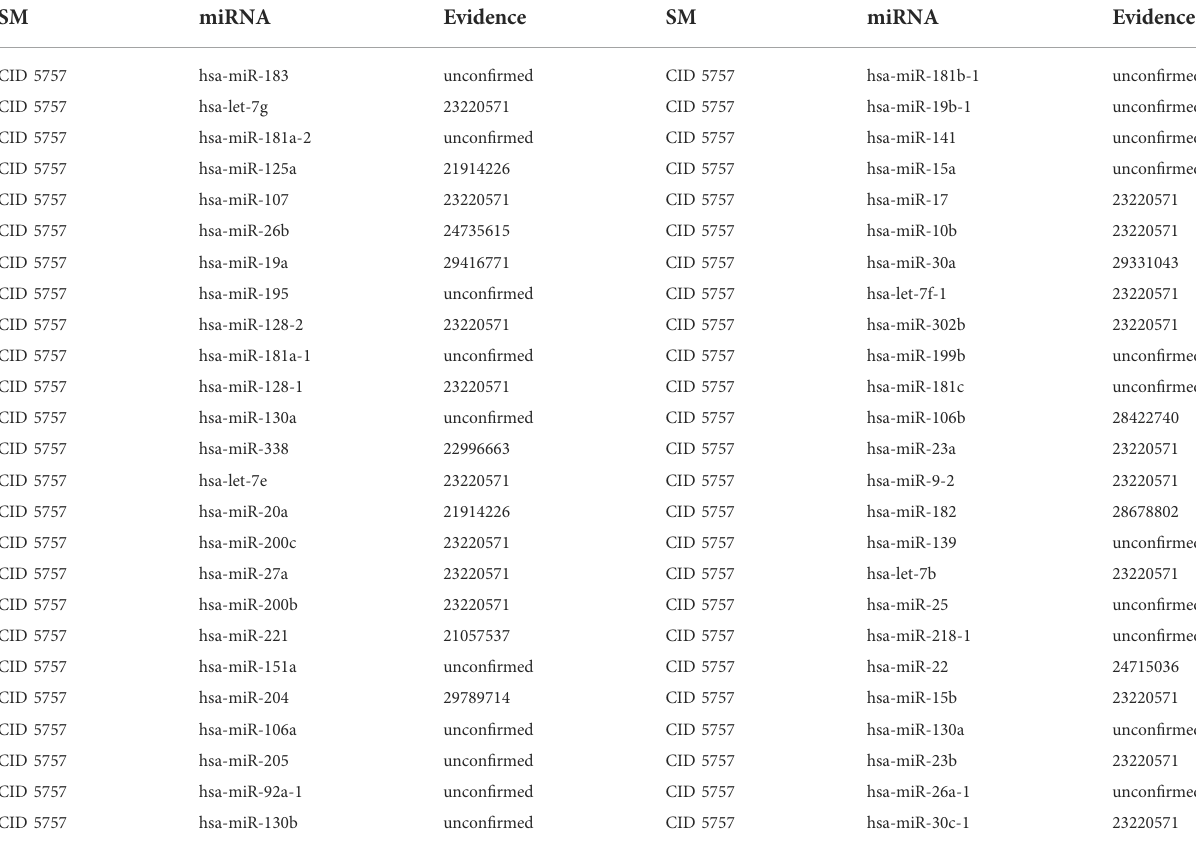
TABLE 7 Validation of the top 50 miRNAs associated with E2 in the fi rst type of case studies. The fi rst column records the top 1 – 25 related miRNAs. The second column records the top 26 – 50 related